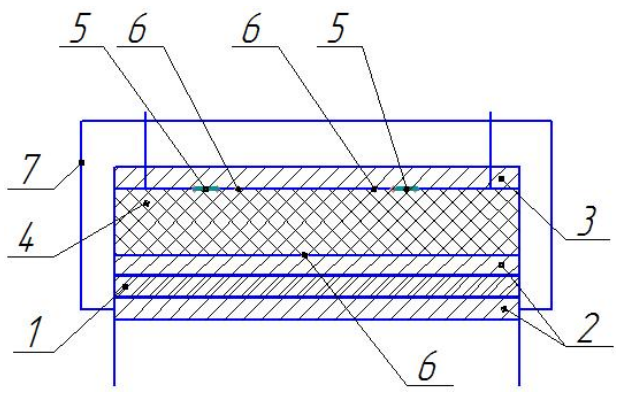
Figure 1. The scheme of the measurement setup: 1—heater, 2—hot plate, 3—cold plate, 4—sample, 5—heat flow sensors, 6—chromel-alumel thermocouples, 7—metal protective casing. 5—heat flow sensors, 6—chromel-alumel thermocouples, 7—metal protective